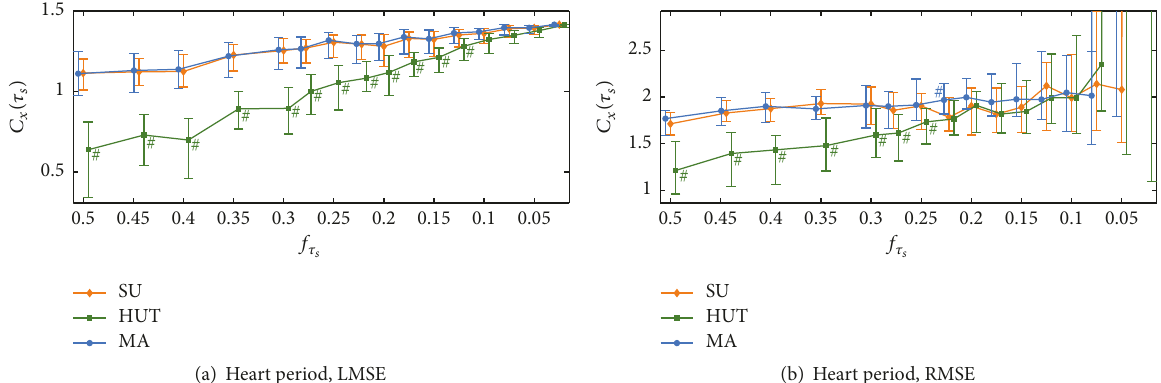
Figure 3: Estimation of multiscale entropy (MSE) for the time series of the heart period. Plots depict the distributions (median and 25th–75th percentiles) of the MSE estimates (𝐶 𝑥 (𝜏 𝑠 )) computed as a function of the cutoff frequency of the low-pass filter used to eliminate the fast ) in the resting supine position (SU, diamonds), during postural stress induced by head-up tilt (HUT, temporal scales of the process (𝑓 𝜏 𝑠 squares), and during mental stress induced by mental arithmetics (MA, circles). While MA does not induce changes, HUT evokes a significant reduction of the complexity of heart period variability, which is observed using LMSE across a wide range of time scales including both low- and high-frequency oscillations. # Statistically significant difference, HUT versus SU or MA versus SU.